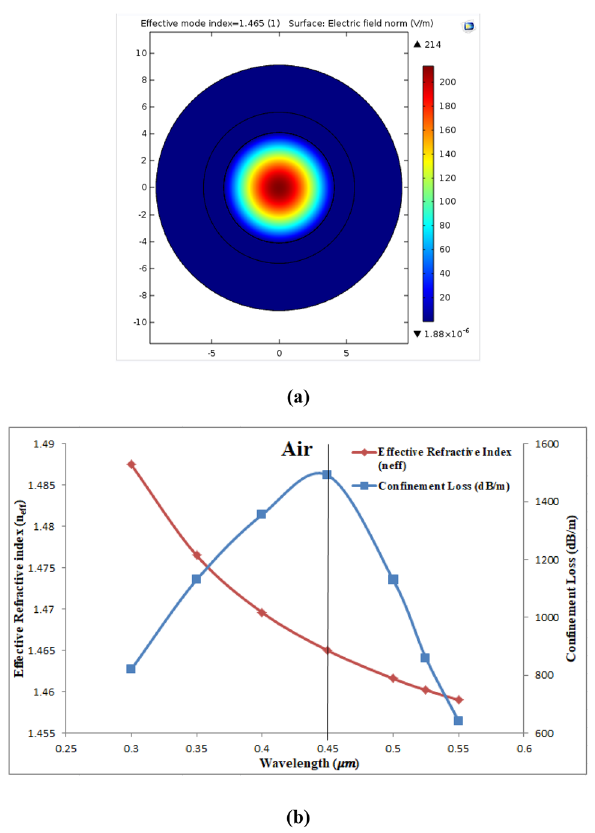
Figure 16. Presents ( a ) the fundamental mode of with air at 0.45 µm and ( b ) the confinement loss (dB/m) and n eff curves of Air as a function of